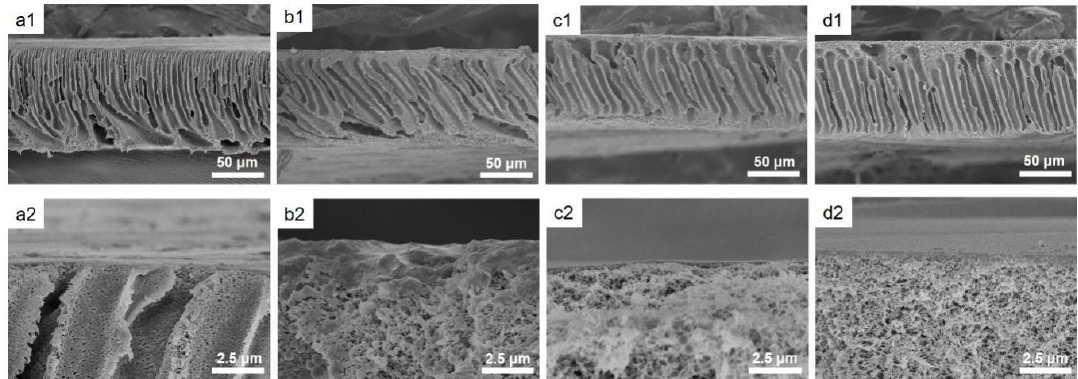
Figure 7. SEM images of cross-section morphologies of PSf ( a1 , a2 ), PSf-1BL ( b1 , b2 ), PSf-3BL ( c1 , c2 ), and PSf-5BL ( d1 , d2 ) membranes.